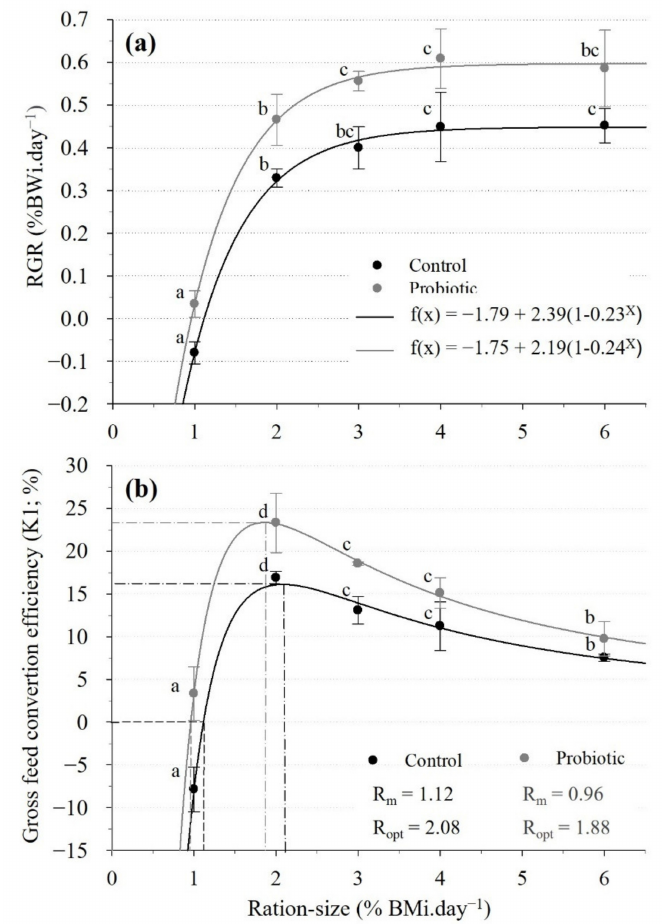
Figure 1. ( a ). Growth-ration (GR) curves determined per diet group from tank mean data and ( b ) Gross feed conversion-efficiency ratio (KR) curves determined per diet group from respective GR curves over the 27-day trial duration. Optimum ration size for growth (Ropt; broken lines) were calculated from the first order derivative of the KR equation (i.e., when (dRGR/x)/dT = 0). Data shown as mean ± SD, n = 3 with 4 shrimps/tank assessed. Different letters indicate significant differences between ration sizes within diets (Student-Newman-Keuls test; p <